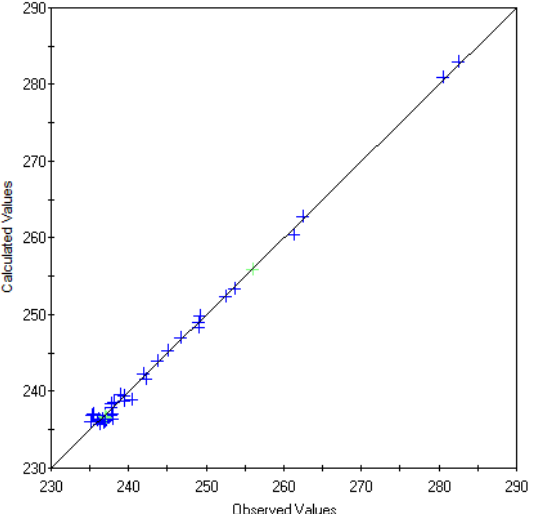
Figure 10. Comparison of the water table ordinates [m a.s.l.] obtained from the model (calculated values) and those observed in reality (observed values) for the adopted calibration points (blue—Middle Devonian, green—Quaternary).